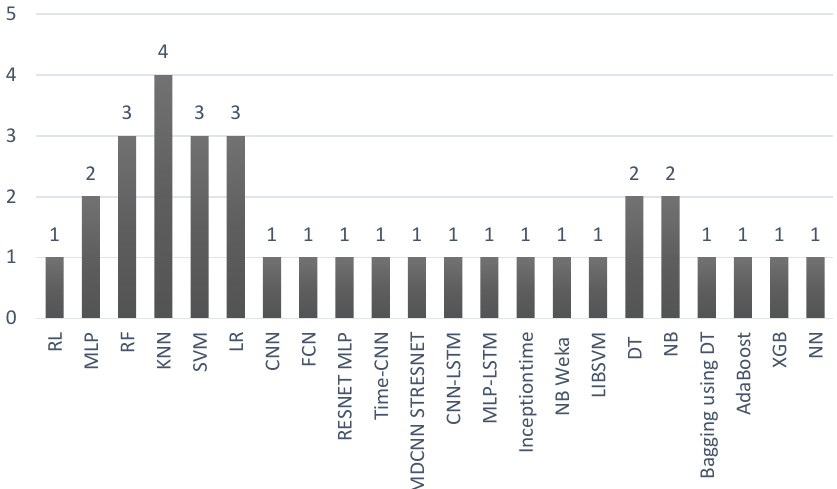
Figure 8. Different techniques of machine and deep learning mentioned in the reviewed literature. The X-axis concerns the machine learning and deep learning algorithms found in the investigated papers. The abbreviations are listed in the appropriate section at the end of this paper. The Y-axis is the number of times each algorithm was identified in the research works.